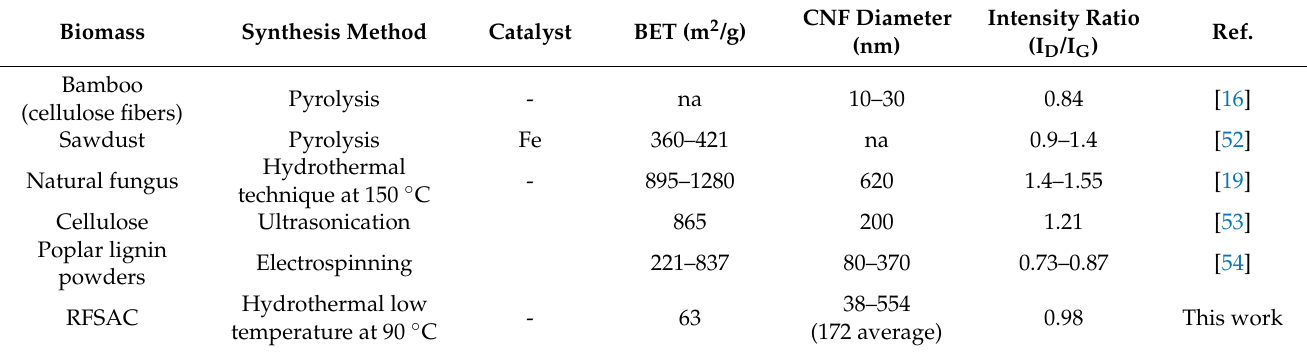
Table 2. The performance of carbon nanofiber prepared from various biomass raw